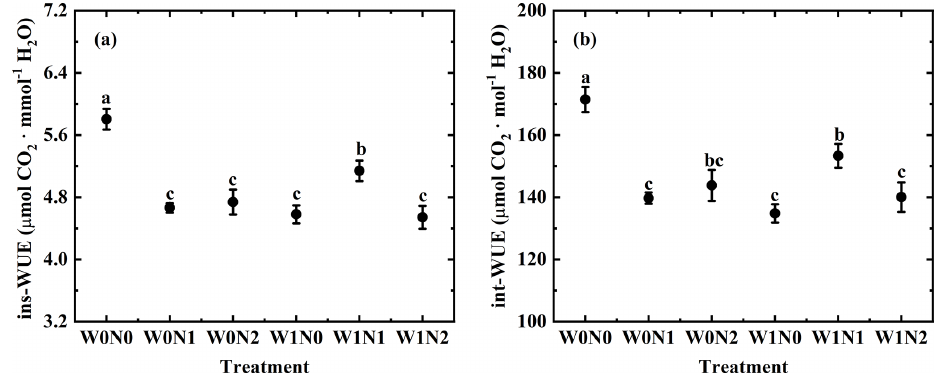
Figure 3. Variations in ins-WUE (a) and int-WUE (b) across water (W) and nitrogen (N) additions. The spot represents the mean value of four replicates with error bars denoting the standard error